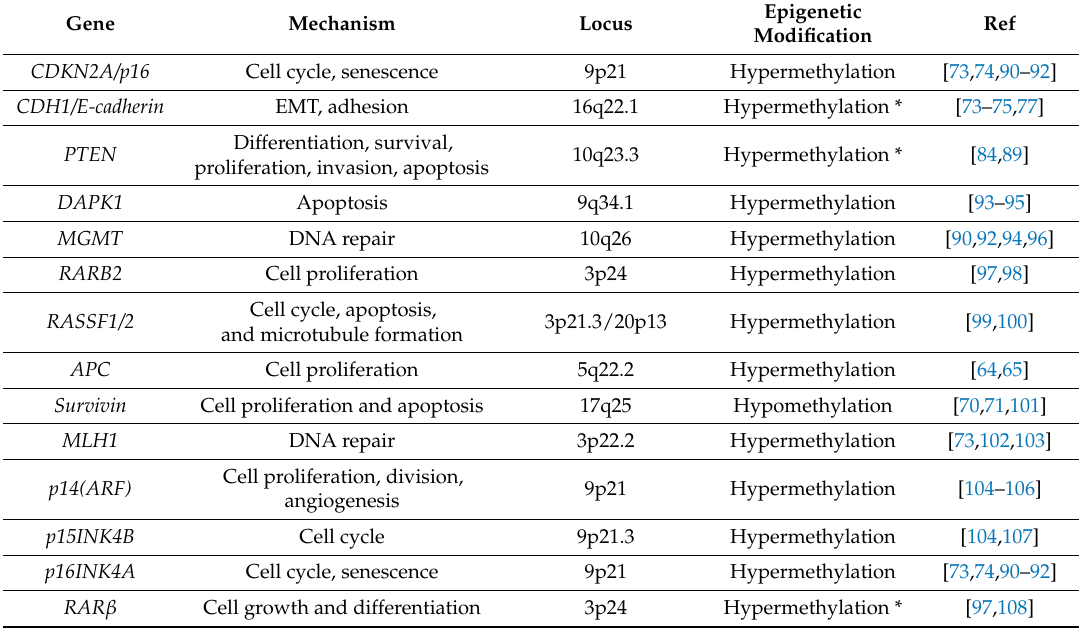
Table 1. Epigenetically regulated genes with implications in oral cancer